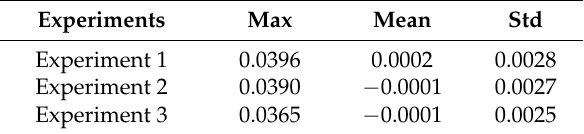
Table 5. Error statistics of robustness results between proposed model and algorithms.